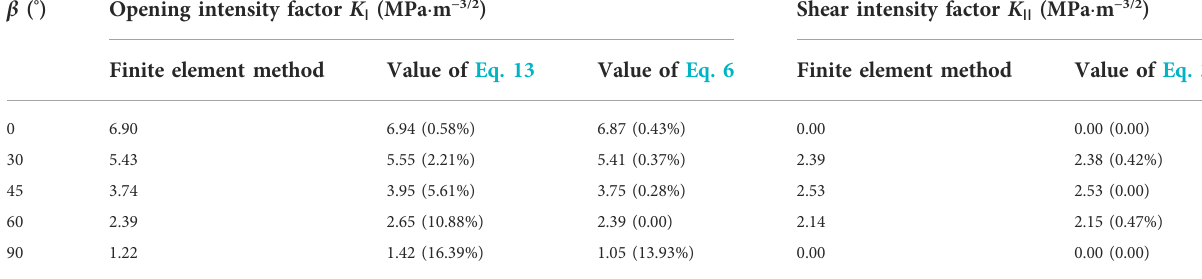
TABLE 5 Values of stress intensity factors derived from different methods and relative error between